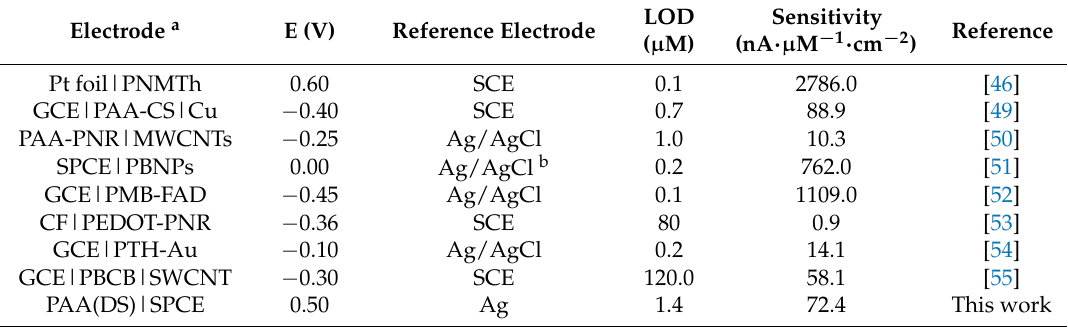
Figure 6. Amperometric response of a bare SPCE (black line) and a PAA(DS)|SPCE (red line) upon successive additions of 10 µM H 2 O 2 in phosphate buffer solution (pH 7) at 0.5 V. The inset shows the calibration straight line obtained from the current for the PAA(DS)|SPCE. Error bars are related to the standard deviation of three different measurements. Table 2. Comparison of the electroanalytical parameters used for a variety of electrodes modified with different CPs for the non-enzymatic sensing of H 2 O 2